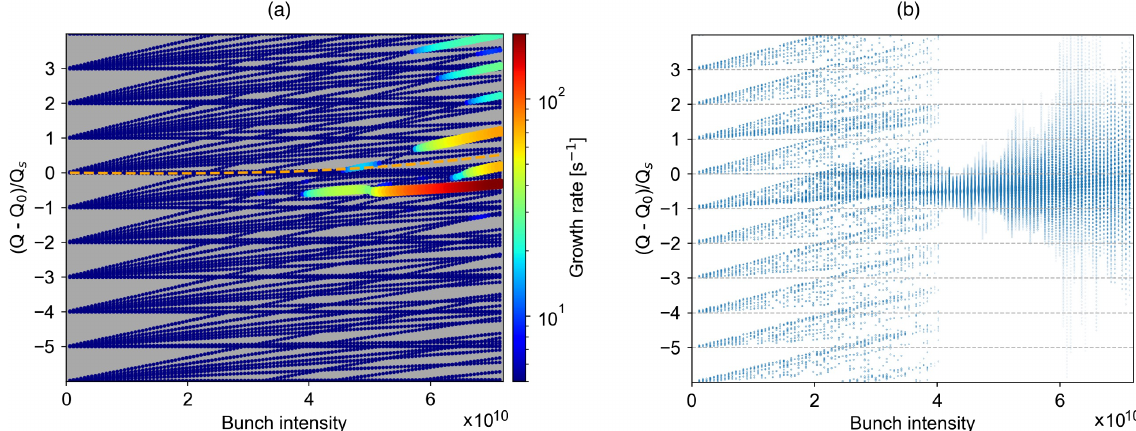
FIG. 15. Same as in Fig. 13 for the case W quad ð z Þ ¼ þ W dip ð z Þ . (a) Eigenvalues from linearized Vlasov equation (b) P y HEADTAIL